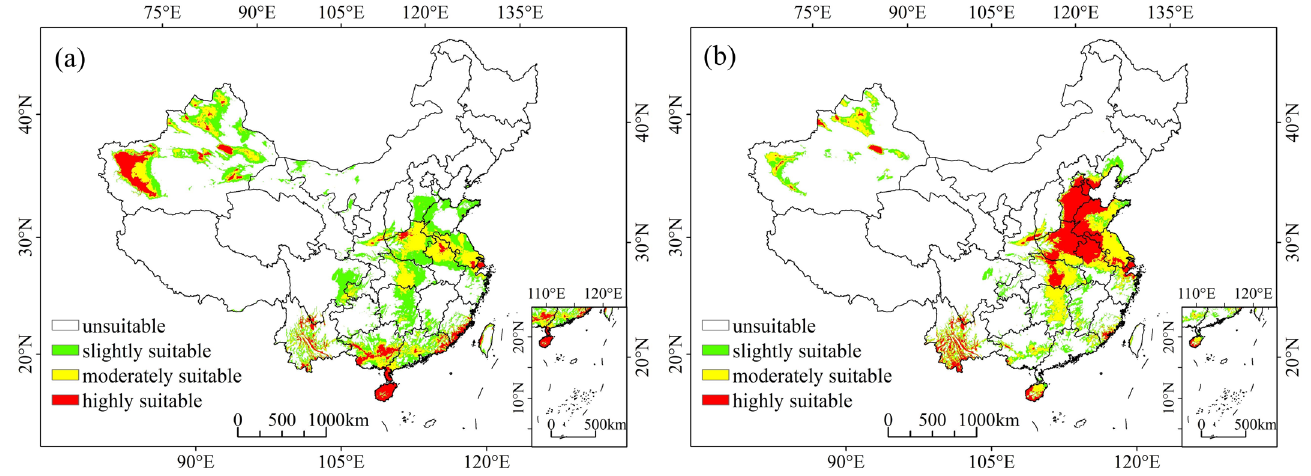
Figure 2. Suitable habitat distribution of ( a ) MEAM1 and ( b ) MED cryptic species of the Bemisia tabaci species complex in China under current climatic